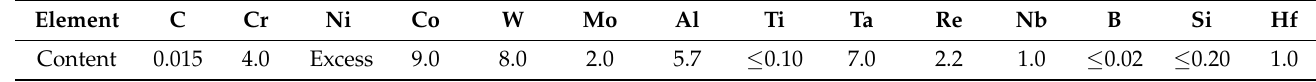
Table 1. Composition of the used Ni-based single-crystal superalloy (mass